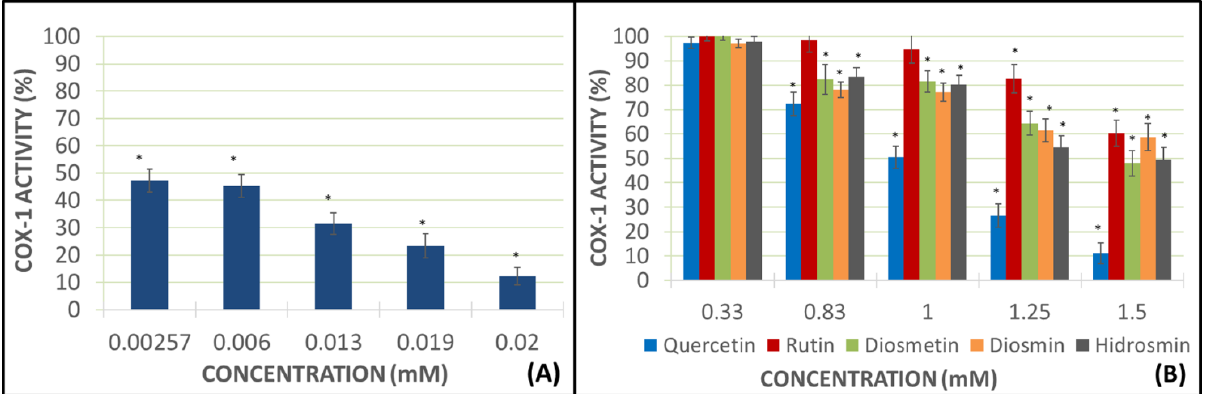
Figure 3. MDA production is represented as the COX-1 activity in the presence of indomethacin (panel ( A )) and each flavonoid at different concentrations (panel ( B )). Error bars indicate the standard deviation. Color bars describe the mean and standard deviation for N = 8. * p < 0.05: significant variations respecting COX-1 activity in presence or absence of the assayed